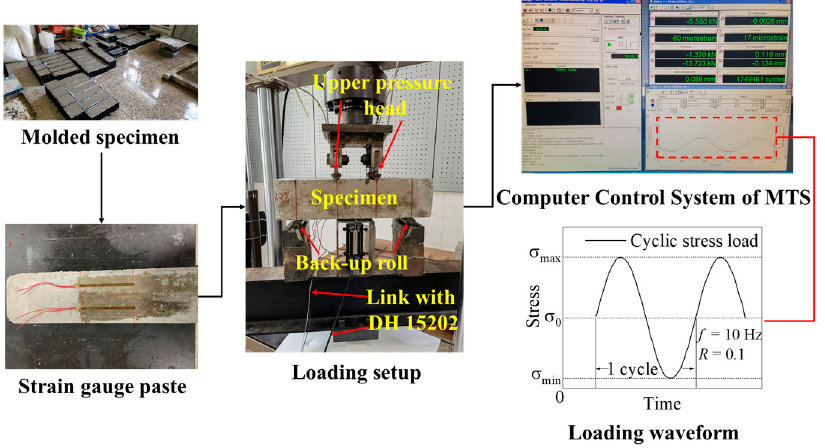
Figure 3. Experimental flowchart.